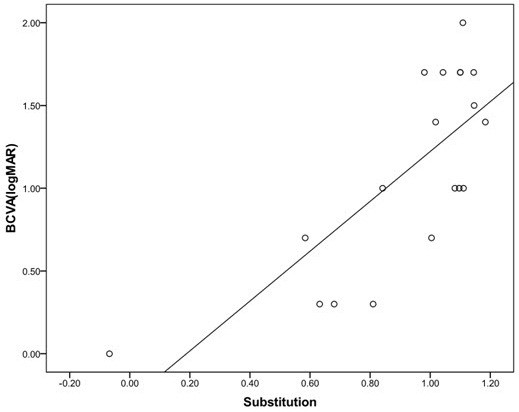
The correlation between actually measured visual acuity and calculated visual acuity. The visual acuity calculated by substituting the amplitude value of patients with optic neuritis into the function was 0.93 ± 0.30. The difference in the average between actually measured visual acuity and function value was 0.18 ± 0.4, indicating no statistically significant difference (t test, P = 0.07).